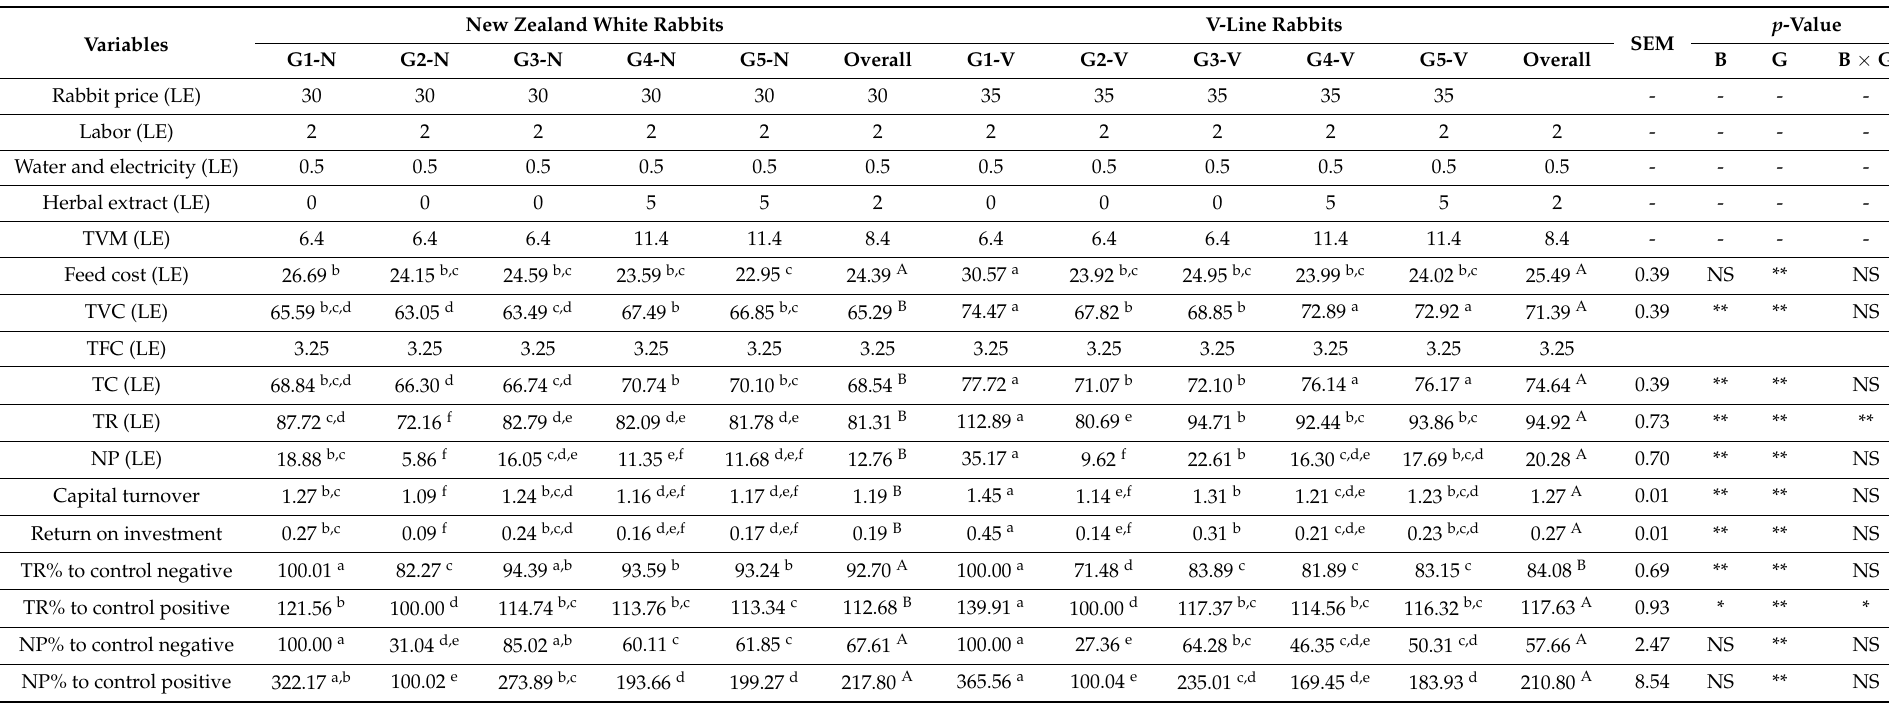
Table 8. Economic efficiency of the New Zealand white and V-line rabbits in response to coccidial infection and herbal extract